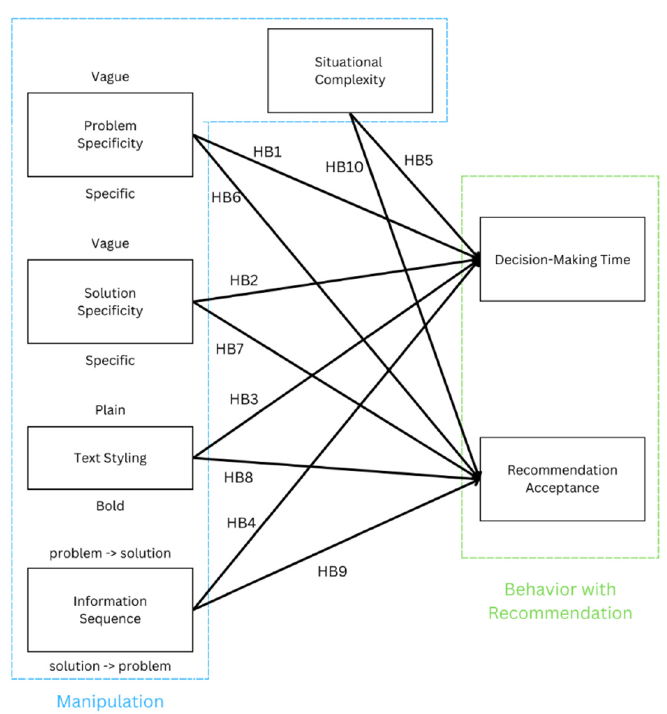
Figure 2. Proposed behavioral research model.